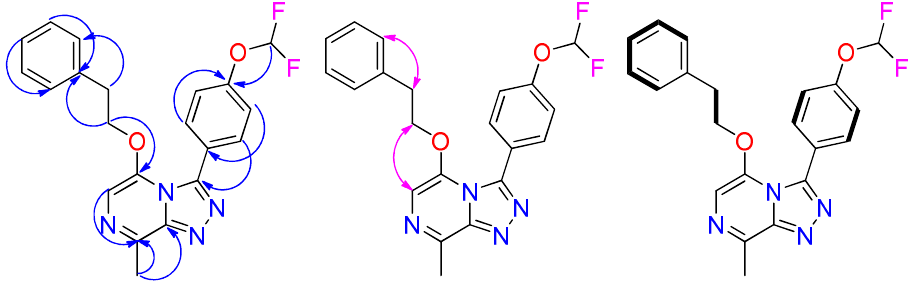
Figure 5. Key HMBC ( → ), ROESY ( ↔ ), and COSY ( — ) correlations for 13 .